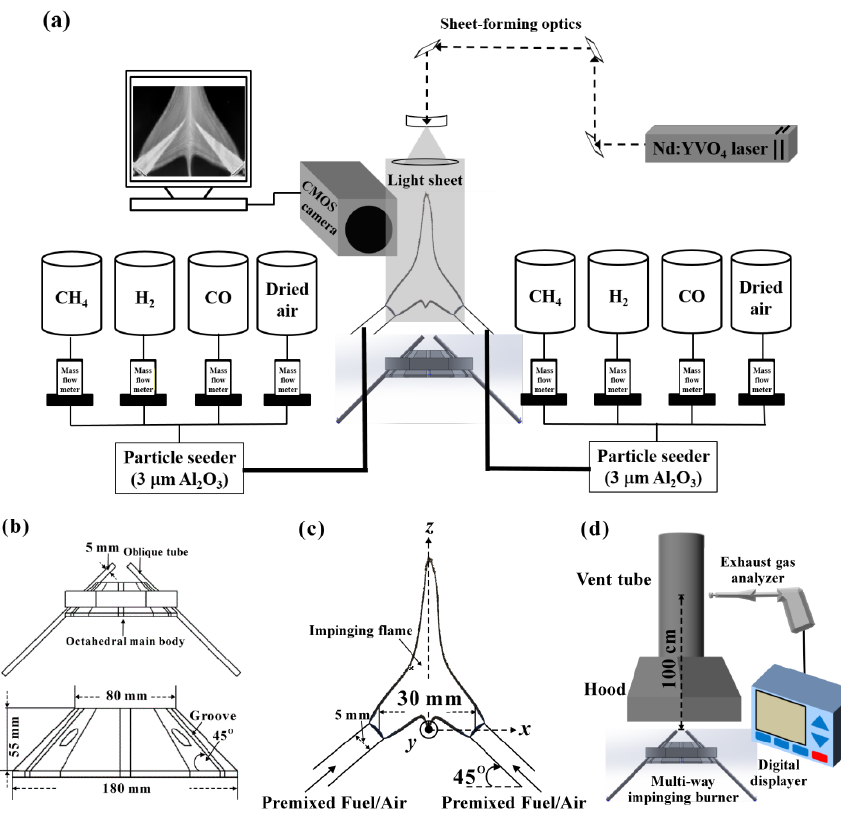
Figure 1. Schematic diagram of the experimental setup ( a ) Schematic description of burner, fuel supply, and image-acquisition system; ( b ) multi-jet inclined injection burner; ( c ) reference coordinate system; ( d ) system for analysis of exhaust.